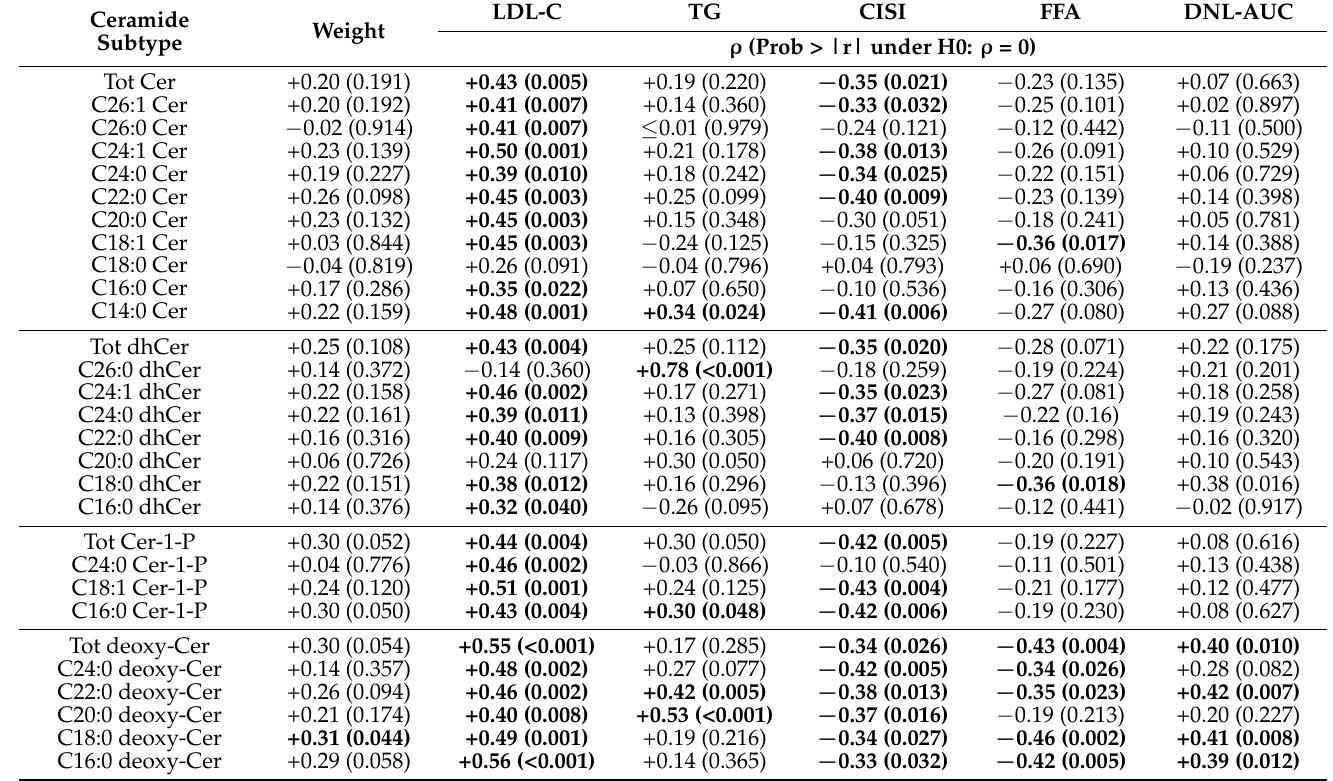
Table 2. Pearson Correlation Coefficient, change in plasma ceramide levels with change in each Weight, LDL-C, TG, CISI, FFA, DNL-AUC from Day 0 to Day